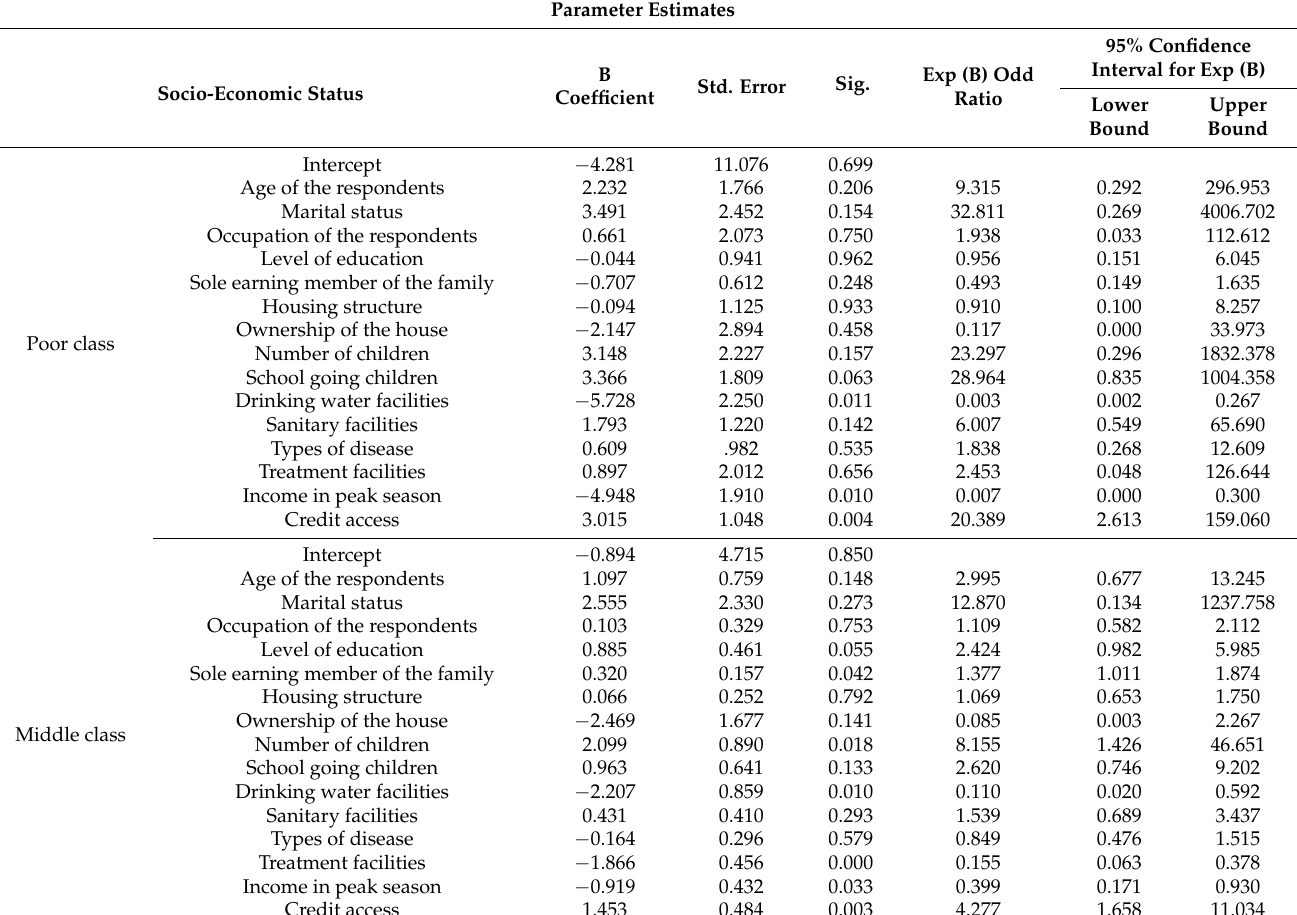
Table 8. Multinomial logistic regression analysis according to the economic status of the studied